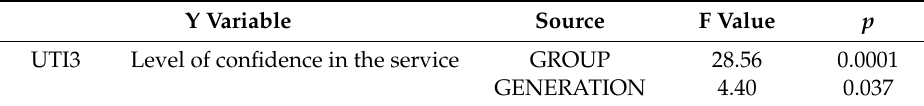
Table 2. Model with UTI3 “Level of confidence in the